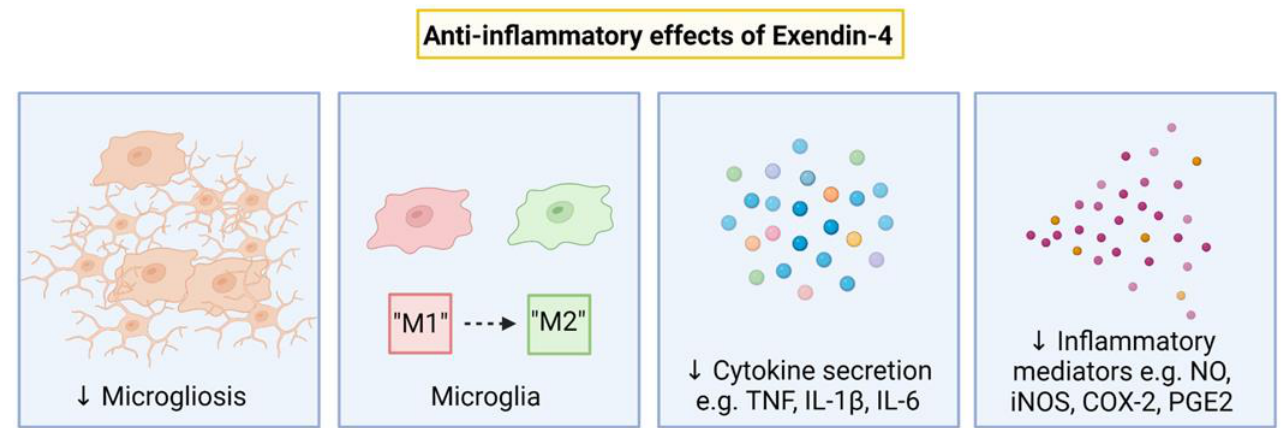
Figure 2. A schematic diagram showing the anti-inflammatory effect of Exendin-4. ↓ :